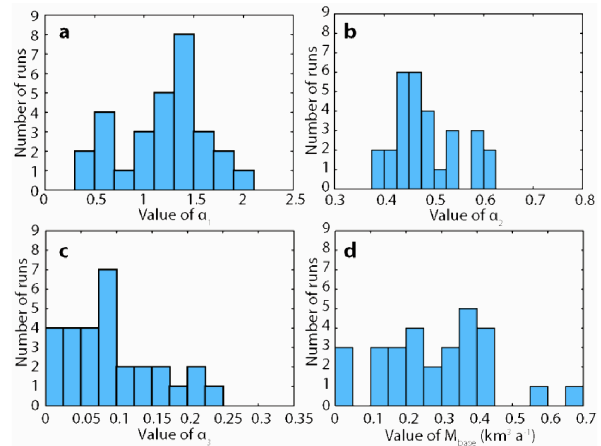
Figure 6. The distribution of the tuning parameters (a) α 1 (bin width: 0.2), (b) α 2 (bin width: 0.025), (c) α 3 (bin width: 0.025), and (d) M base (bin width: 0.05km 3 a − 1 ) for successful runs as de- fined by the criteria outlined in the text. Minimum and maximum x -axis values represent the full range of values tested within the 1500 model runs.